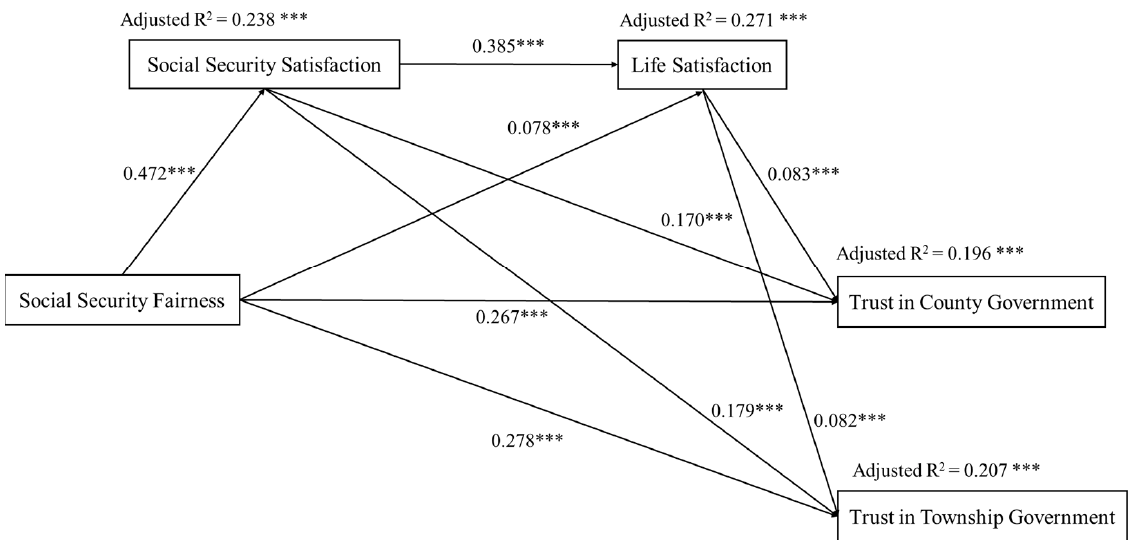
Figure 3. The serial mediator model of social security fairness, social security satisfaction, life satisfaction, and trust in local (county and township) government after adding the control variables ( n = 7403). Standardized regression coefficients are shown next to the arrows. Adjusted R 2 is shown above the explained variable. *** p < 0.001.